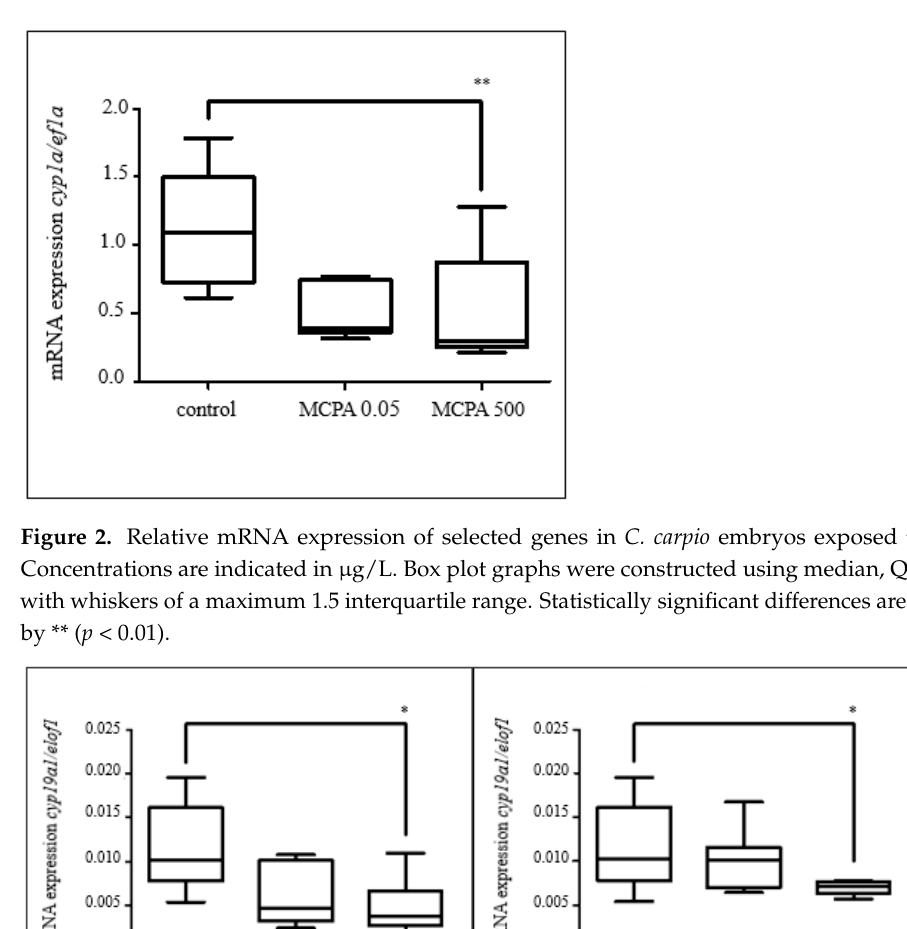
Figure 1. Relative mRNA expression of selected genes in D. rerio embryos exposed to various pesti- cides. Concentrations are indicated in µg/L. Box plot graphs were constructed using median, Q1, Q2 with whiskers of maximum 1.5 interquartile range. Statistically signi fi cant di ff erences are indi- cated by * ( p < 0.05) or ** ( p < 0.01).